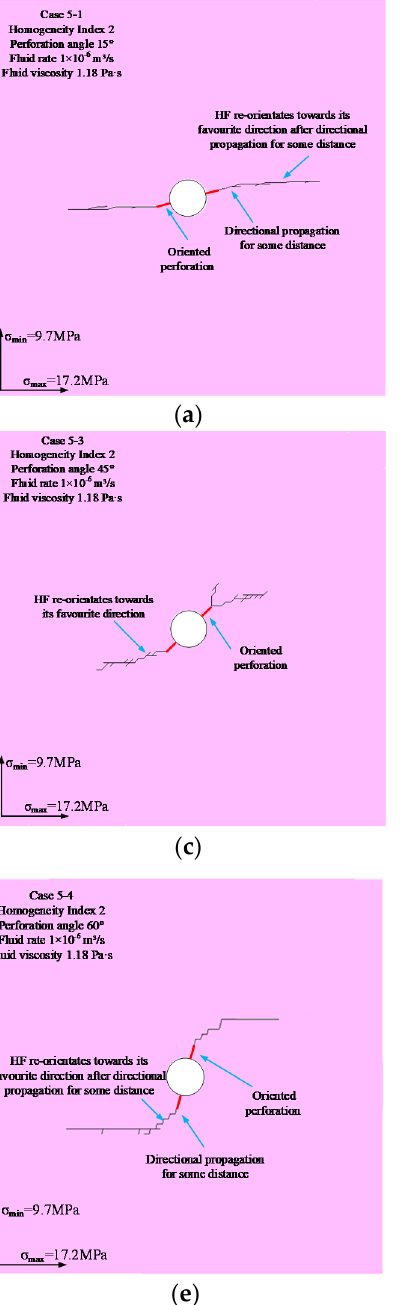
HF re-orientates directly towards its favourite direction after directional propagation for some distance